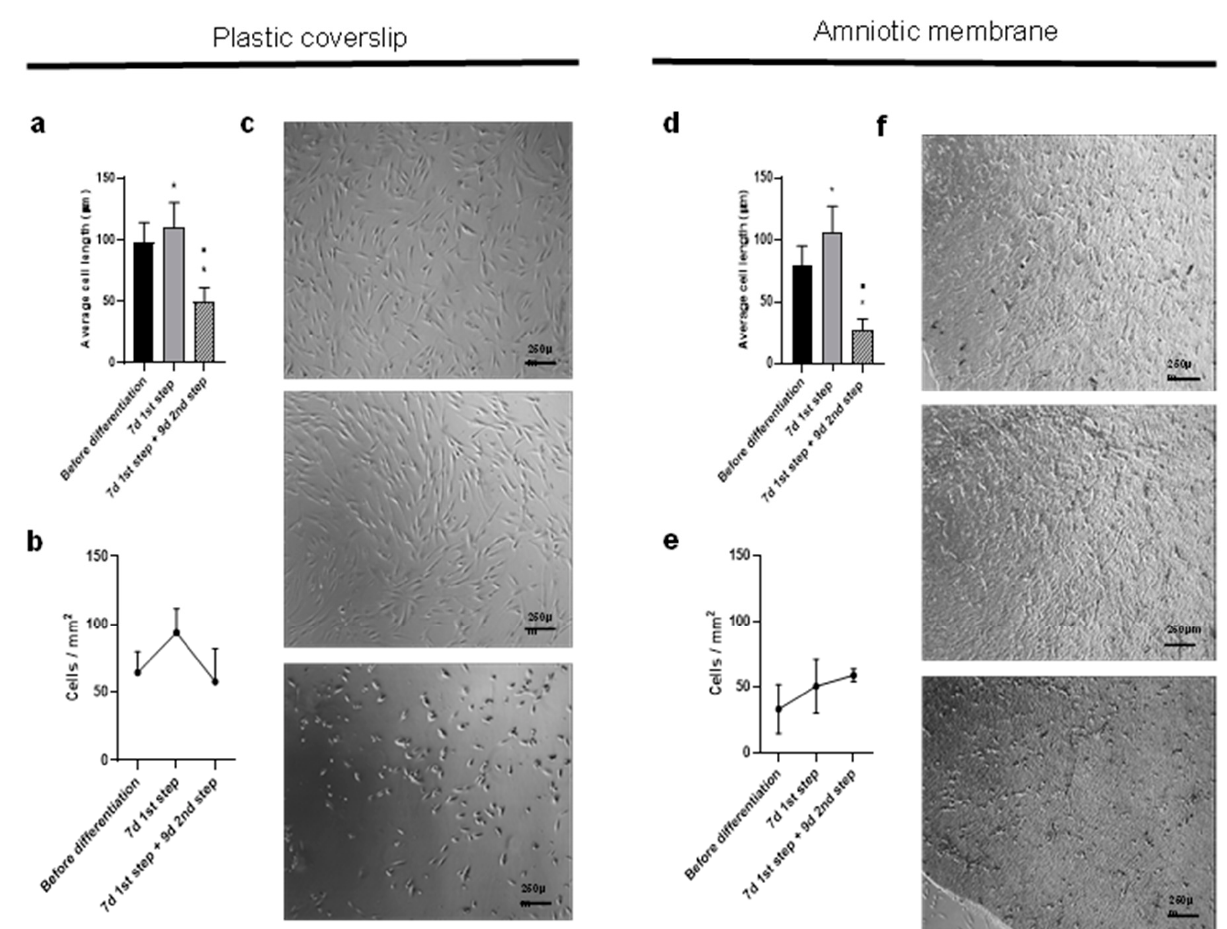
Figure 4. Differentiation kinetics, morphology and cell numbers during differentiation of AD- SCs into LSCs. Mean cell length (in μ m) ( a , d ), cell numbers per mm 2 ( b , e ) and phase contrast images ( c , f ) before differentiation (top), after the first step (middle) and after the second step (bottom). All images feature a scale bar of 250 μ m. Error bars denote standard deviation. We employed the Mann– Whitney U test to assess differences between c-Kit-positive and c-Kit-negative cells; Student’s t-test was employed to assess statistical significance. Data were pooled from 3 separate experiments com- prising 3 wells each. Asterisks (*) indicate statistical significance with respect to before differentiation, and ■ indicates significance with respect to the first differentiation step at p ≤ 0.05.